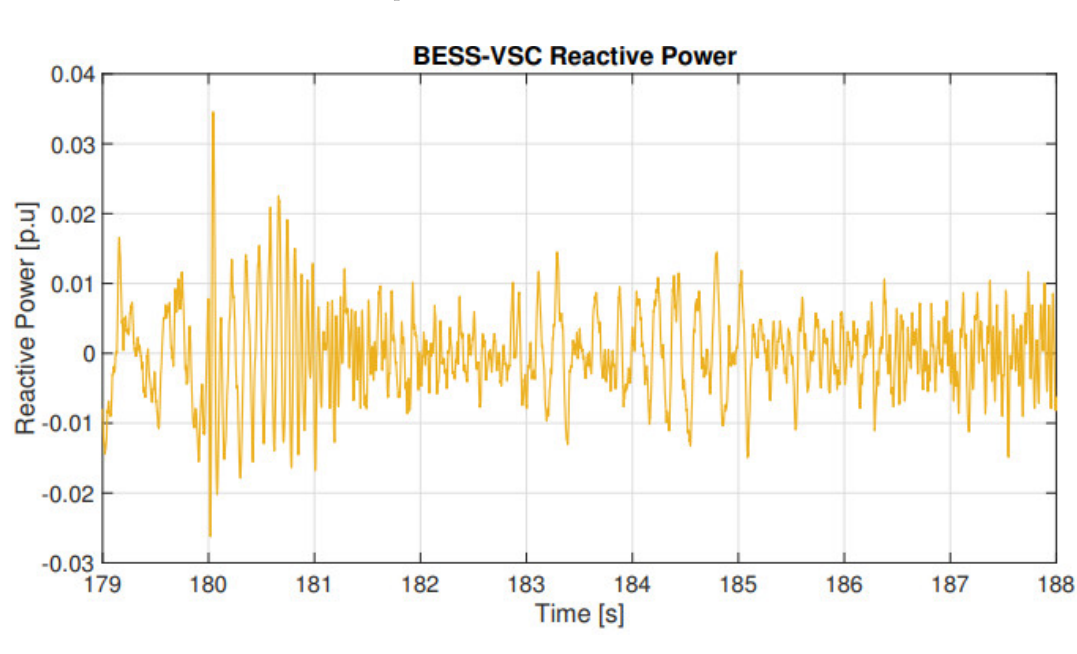
Figure 18. Active power.